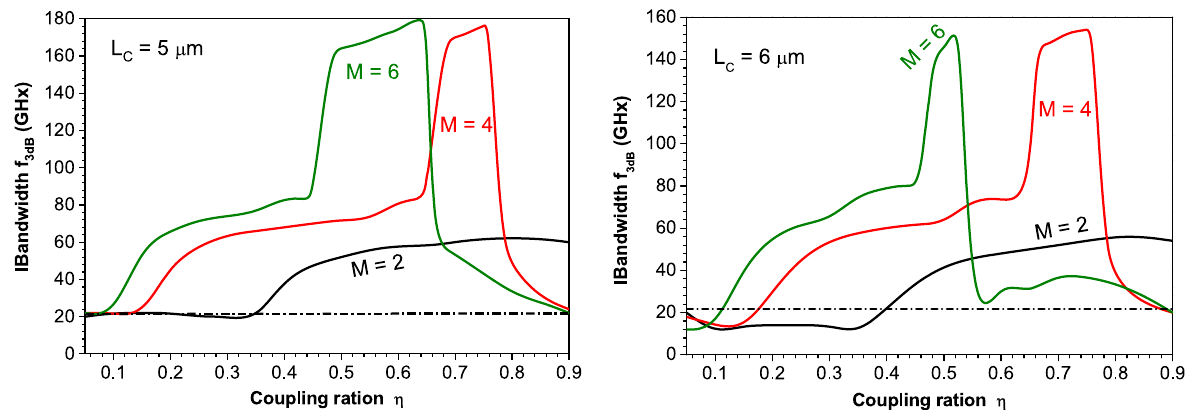
Figure 7: Variation of the bandwidth f 3dB of the TTC VCSEL with the coupling ratio η when (a) L C = 5 μ m and (b) L C = 6 μ m for 2TCC-VCSEL, 4TCC-VCSEL, and 6TCC-VCSEL.